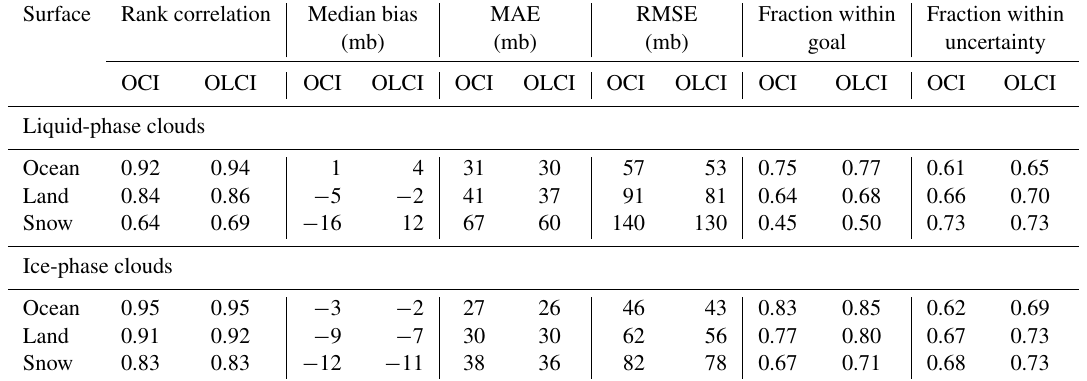
Surface Rank correlation Median bias MAE RMSE Fraction within Fraction within (mb) (mb) (mb) goal uncertainty OCI OLCI OCI OLCI OCI OLCI OCI OLCI OCI OLCI OCI